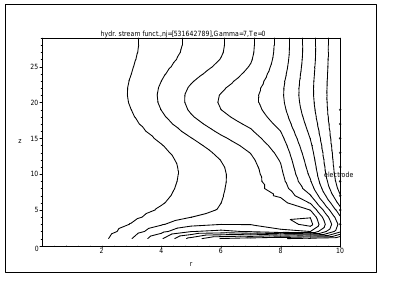
Figure 15. The stream functions for ψ ∈ (0 , 0 . 16) , Γ = 7 , Te = 0 .